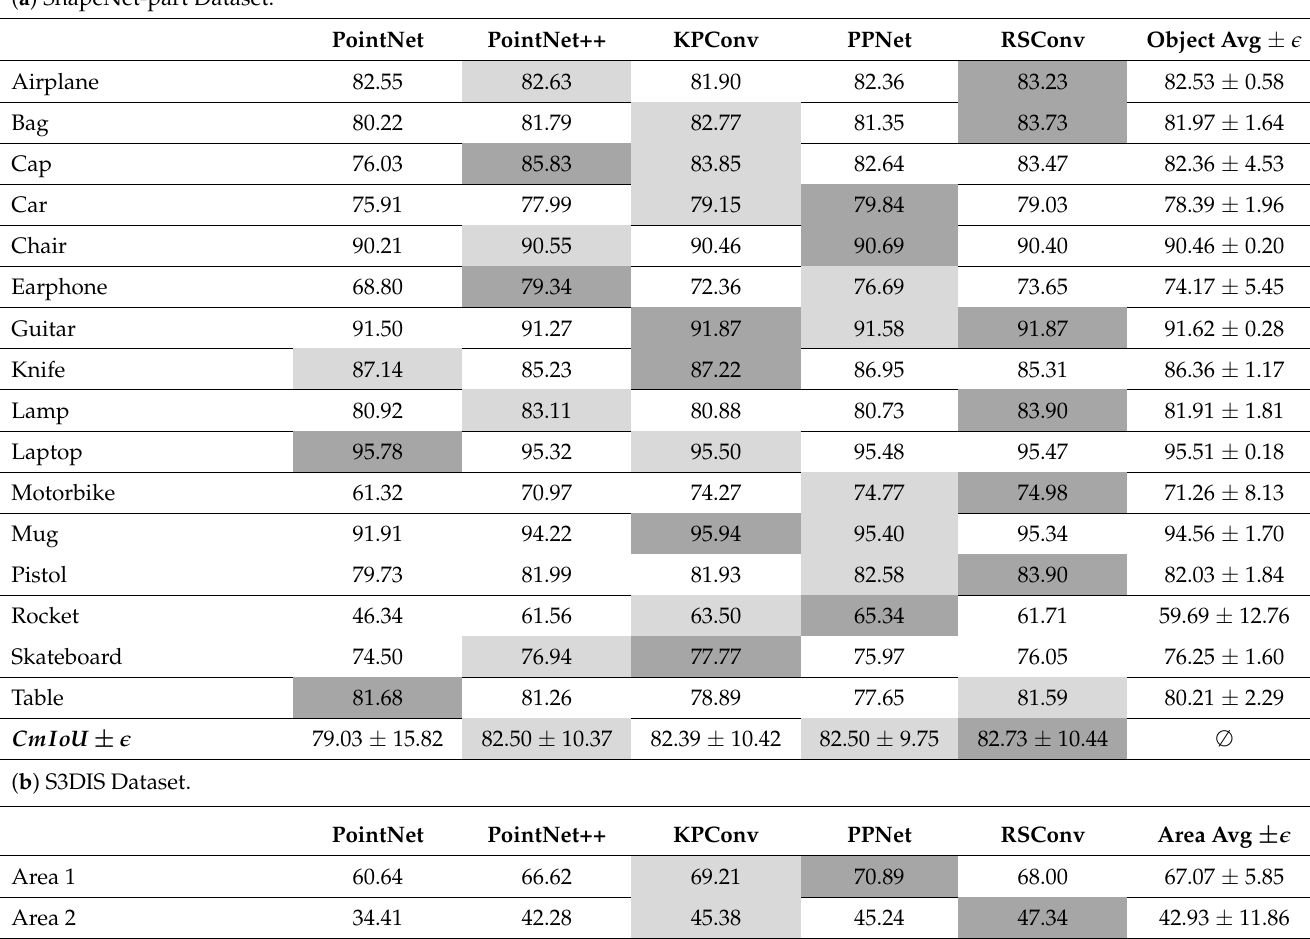
Table 5. Comparisons of deep learning models in terms of best segmentation accuracy. Please note that in the table (a) each row shows the mIoU value for each class and the last row shows the CmIoU , which is the average of all the mIoU per class across all classes for each model and the error of it in percentage values, denoted as (cid:101) . Also in the same format of average ± (cid:101) , we show the per object average and the standard error of the mean. In table (b), we show the best mIoU per Area in each row and, similarly as in table (a), the models’ and Areas’ average and their errors. We use dark grey and light grey cell colors to denote the best and the second-best score in each